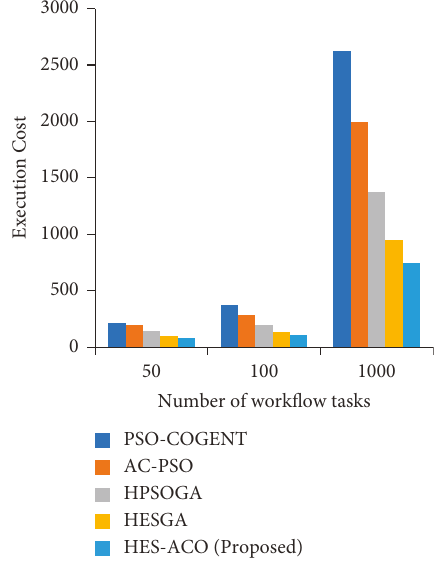
Figure 12: Execution cost for